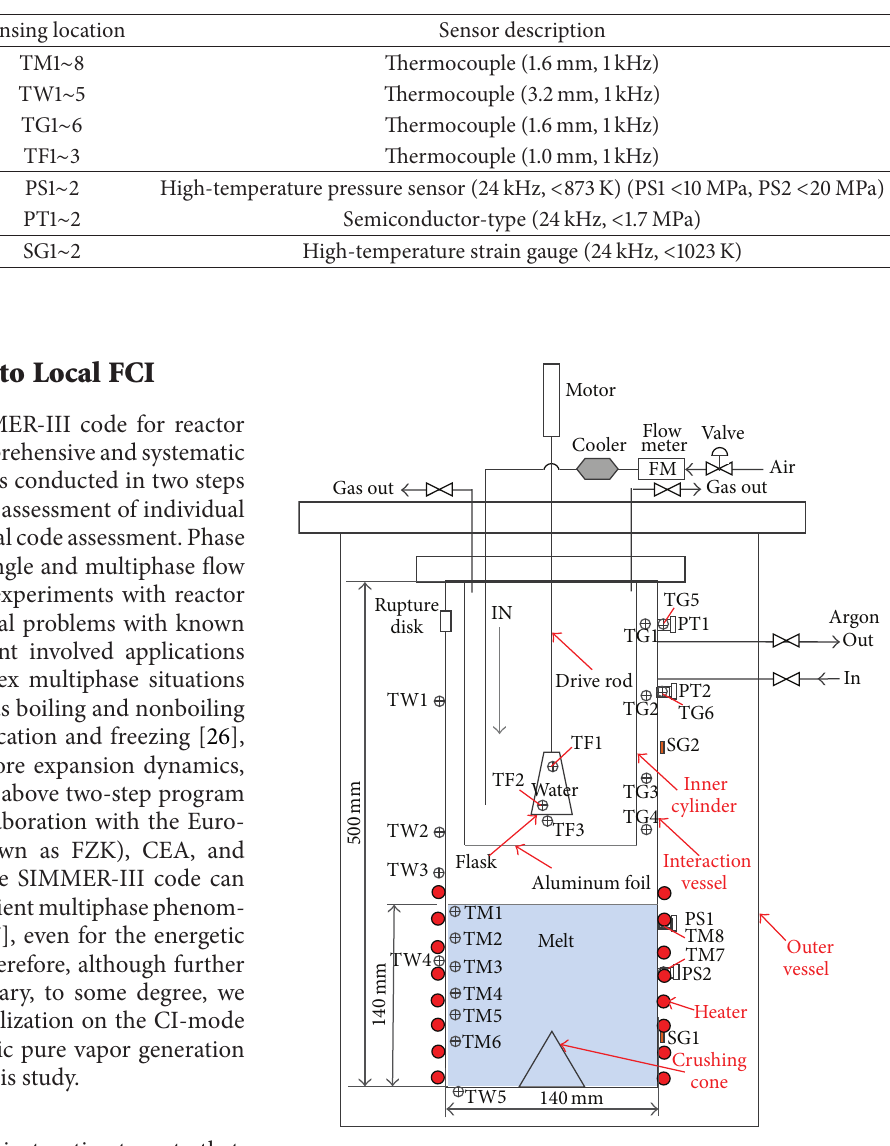
Figure 6: Representative experimental